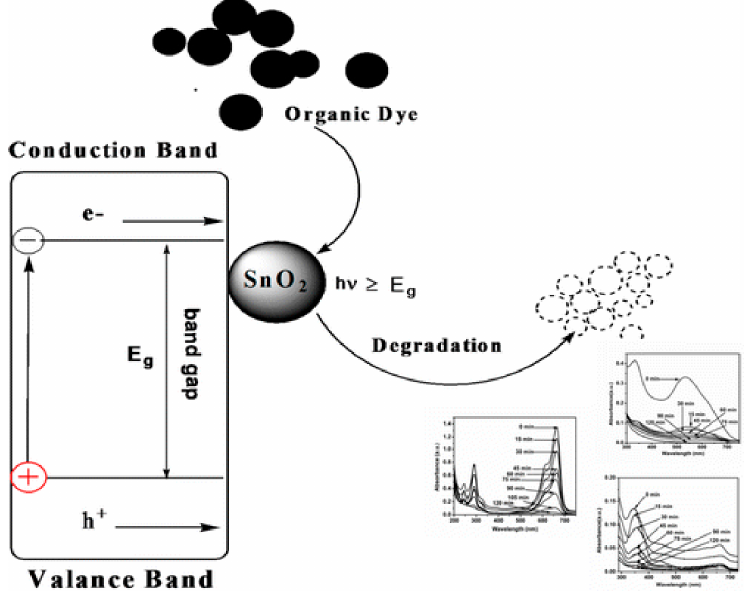
Figure 5. Schematic representation of the photocatalytic degradation process of dyes using SnO 2 nanoparticles (reprint from [70] with permission from the American Chemical Society. Copyright 2014).